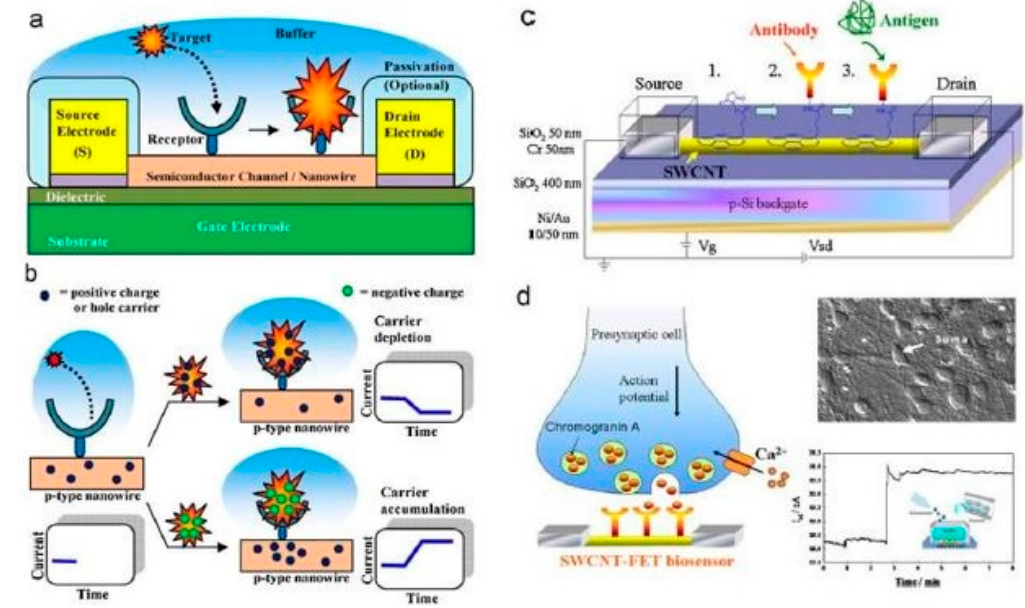
Figure 2. ( a ) Schematic diagram of the nanoscaled-FET silicon-based sensors. ( b ) Binding of the target molecules with the receptors. ( c ) Surface modification of the FET device done with a π - π interaction process, immobilisation and detection. ( d ) Release of the neurons on the sensing surface of the FETs to determine the change in current with respect to the time [81]. The image has been reproduced with permission from [81].